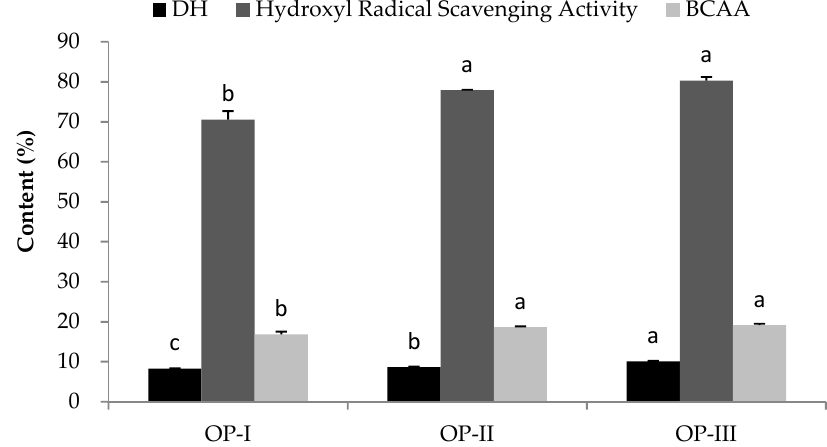
Figure 2. The content of the parameters of different fractions from the OP. Different letters indicate significant differences between groups ( p < 0.05).